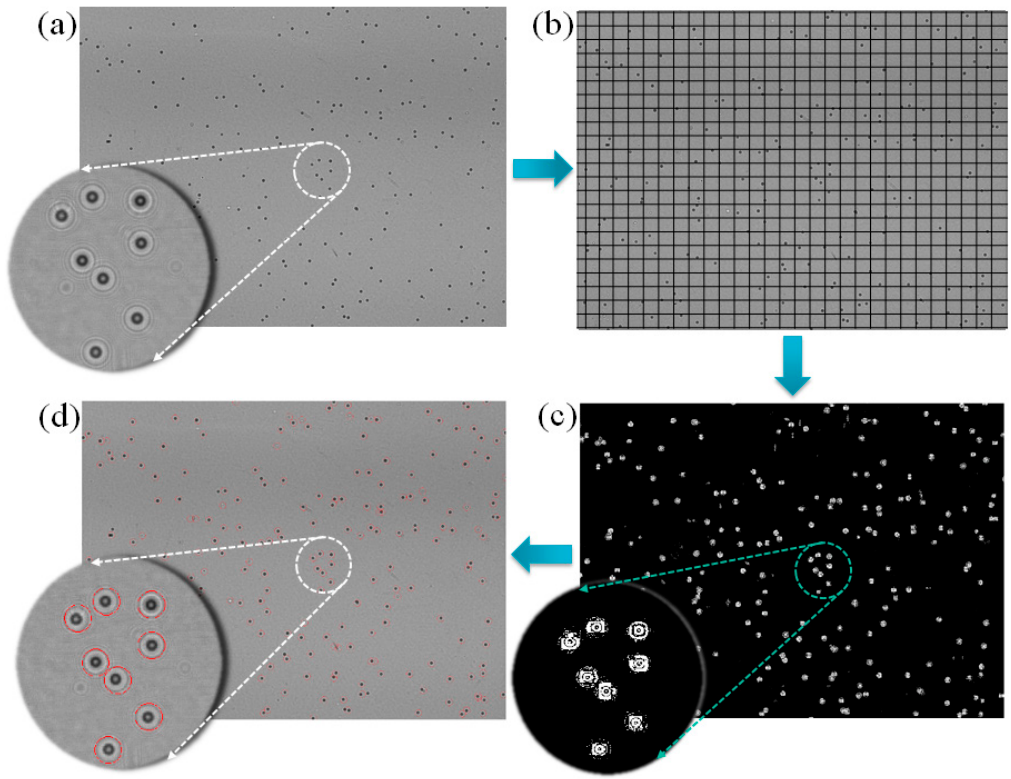
Figure 5. Schematic of the workflow of the algorithm. ( a ) Whole-frame image from the fabricated lens-free imaging system; ( b ) schematic representation (not the actual representation of 10 × 10 window) of the windowing method; ( c ) filtered binary image of ( b ); ( d ) detected and marked diffraction patterns in a whole-frame lens-free image.